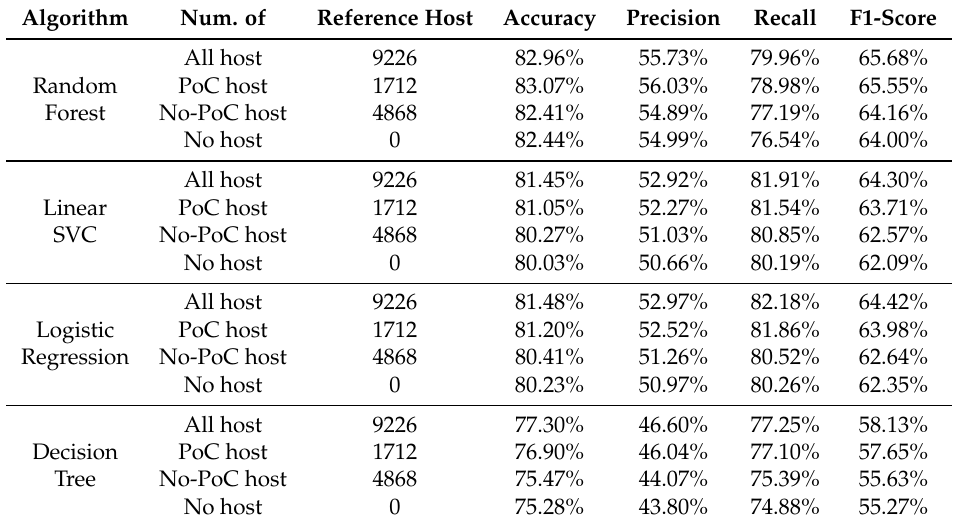
Table 2. Results of the exploit prediction experiment based on Reference